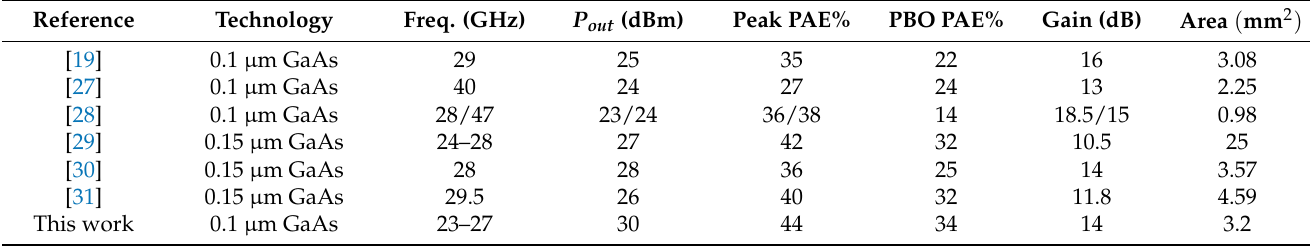
Table 1. Performance comparison of state-of-the-art mm-waves GaAs pHEMT DPAs at the stage of